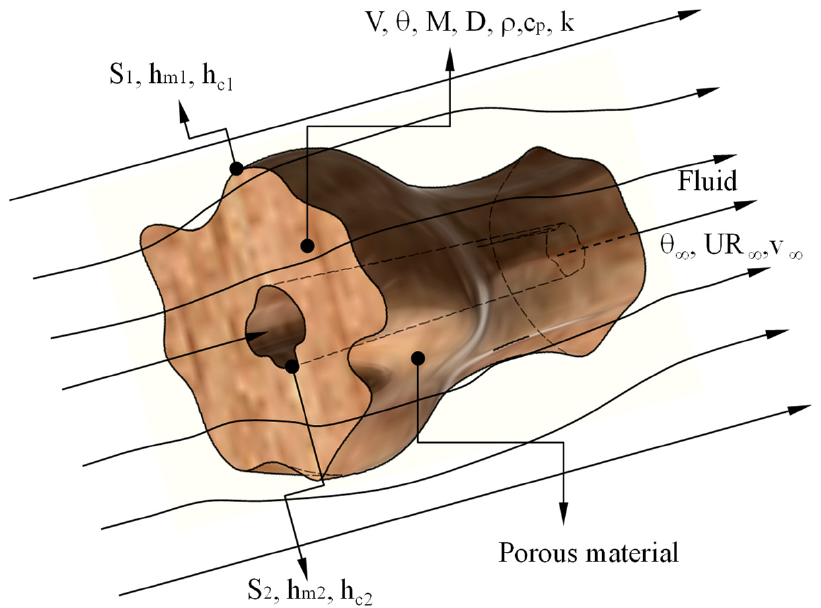
Figure 1. Schematic representation of a solid with arbitrary geometry immersed in a heated fluid.